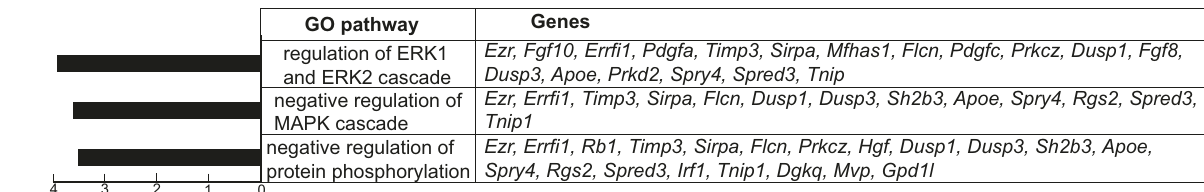
indirect target genes, (3) with chromatin changes, that contain transcription factor binding sites, and (4) without chromatin changes. Overall, we suggest that TBX1 with Isl1, Fox, Six, Pitx , and E-box proteins such as Tcf21 , (Fig. 8e), act together to regulate the progression of MLPs to more differentiated states in the CPM.